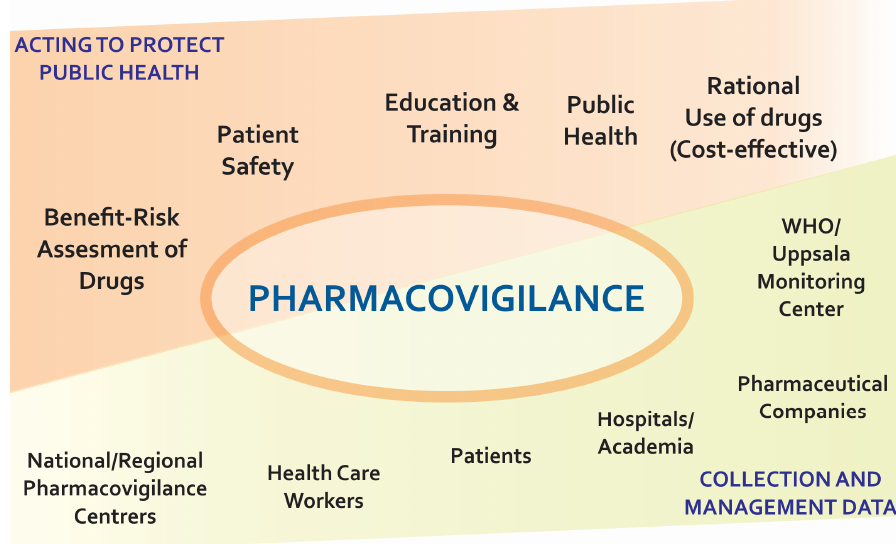
Figure 2. Main actors in the pharmacovigilance process.